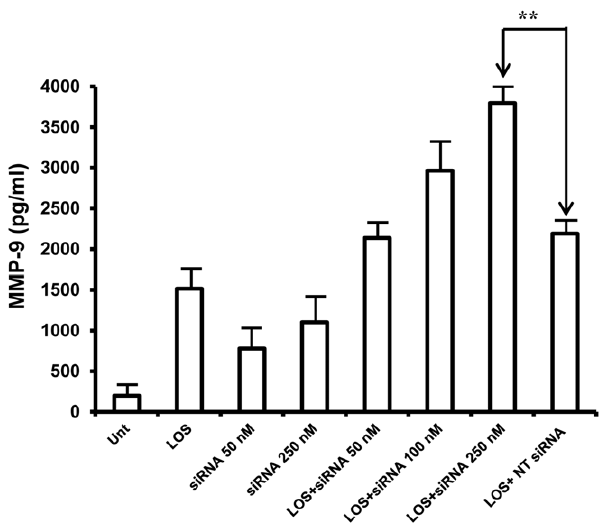
Figure 3. Knock down of JNK1/2 by siRNA enhances secretion of MMP-9 in RAW 264.7 cells. RAW 264.7 cells were transfected with JNK1/2 specific siRNA at various concentration for 30 h and then treated with LOS (100 ng/ml) for another 18 h. Supernatants were collected and levels of MMP-9 were quantitated by ELISA. One representative data from total of three experiments is shown. NT siRNA, non-target siRNA. **( p , 0.05, considered significant).